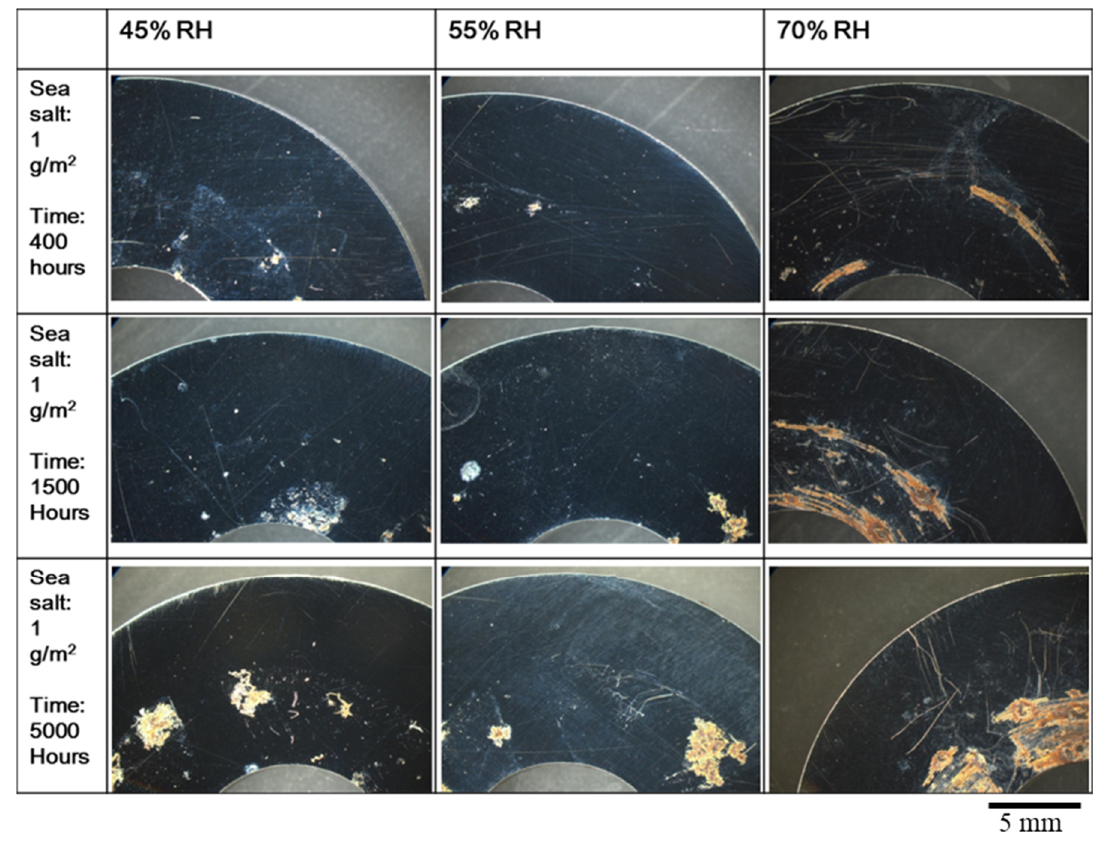
Figure 3. The specimens with 0.1 g/m 2 of sea salt deposited on the surface were tested at different relative humidity levels and temperatures of 45 °C.